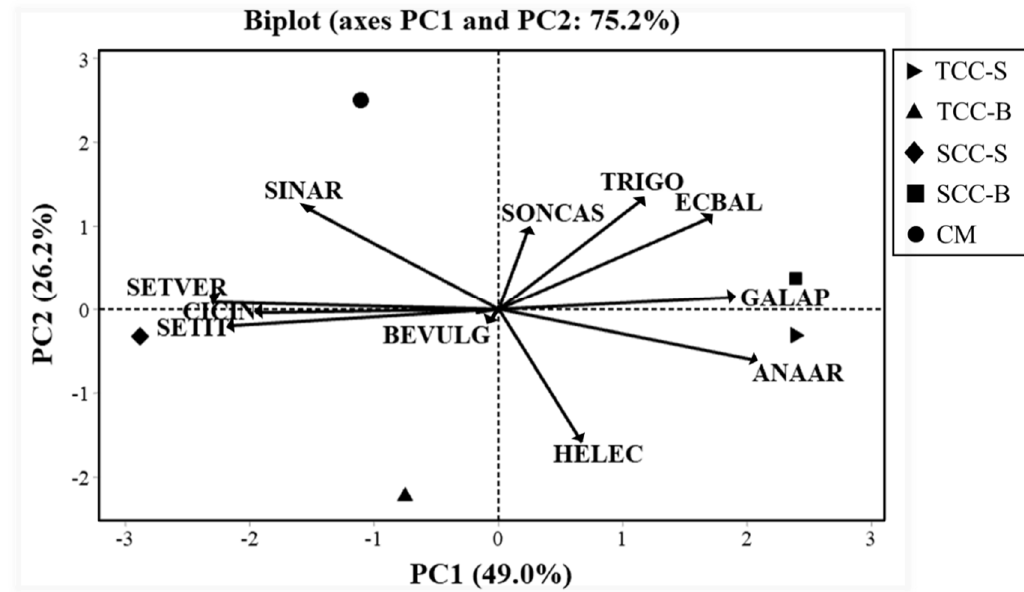
Figure 4. Principal components analysis ordination biplot from the correlation matrix with the 11 most frequent weed species, averaged over seasons, in di ff erent cover cropping treatments. Weeds: ANAAR ( Anagallis arvensis ); BEVULG ( Beta vulgaris ); CICIN ( Cichorium intybus ); ECBAL ( Ecballium